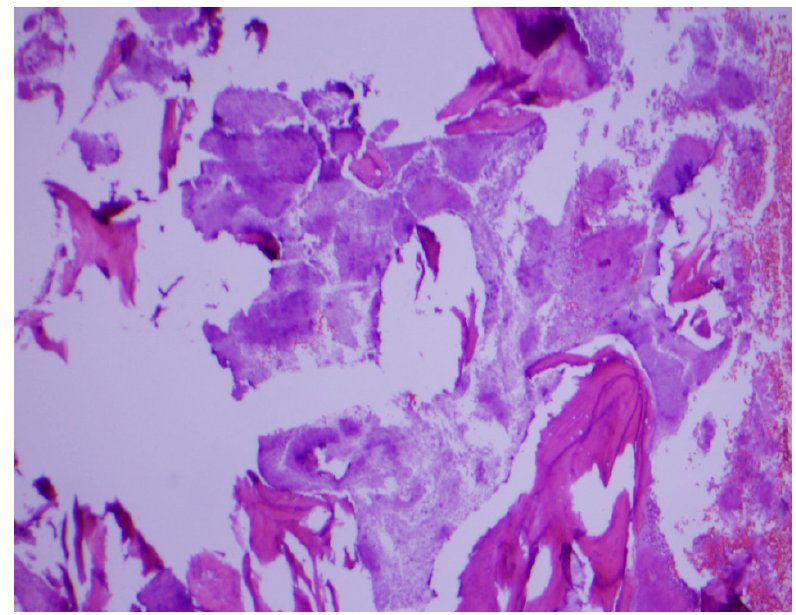
Figure 3. Osteonecrosis of the jaw on hematoxylin and eosin stain. Original magnification ×40.